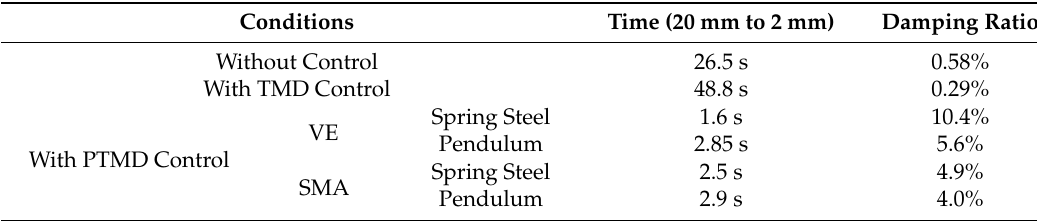
Table 2. The results of free